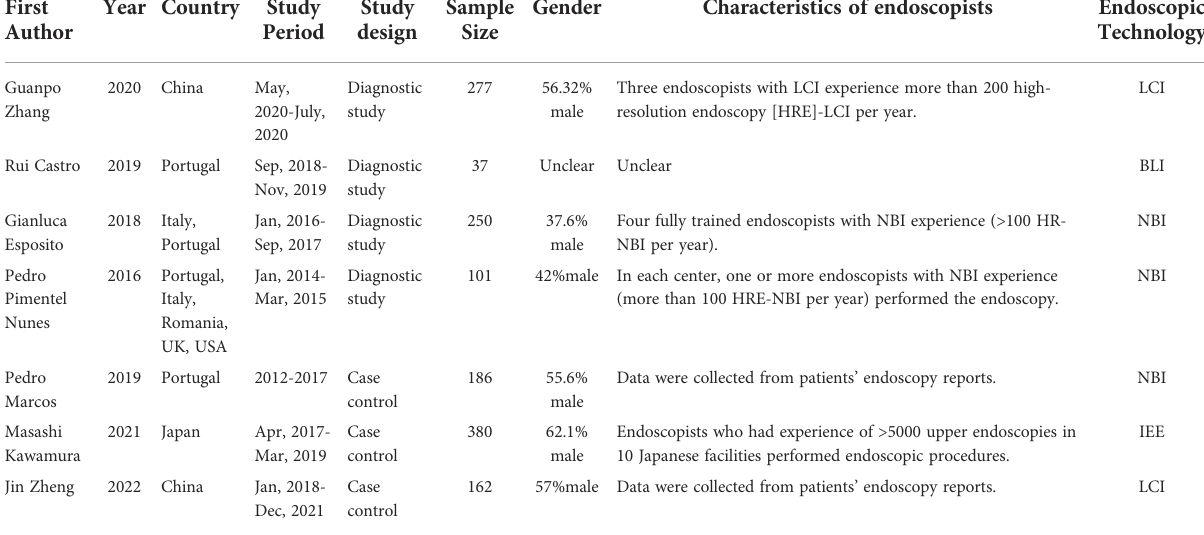
TABLE 1 Characteristics of studies included in the